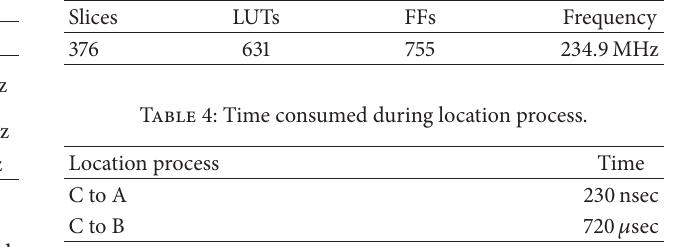
Table 2: Resources used in communication mechanism in compu- tational node.